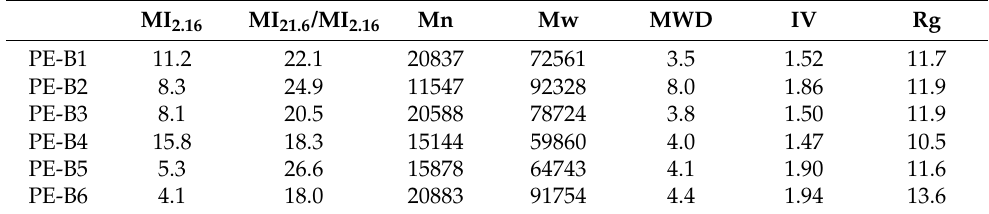
Table 2. Physical and foaming properties of polyethylene